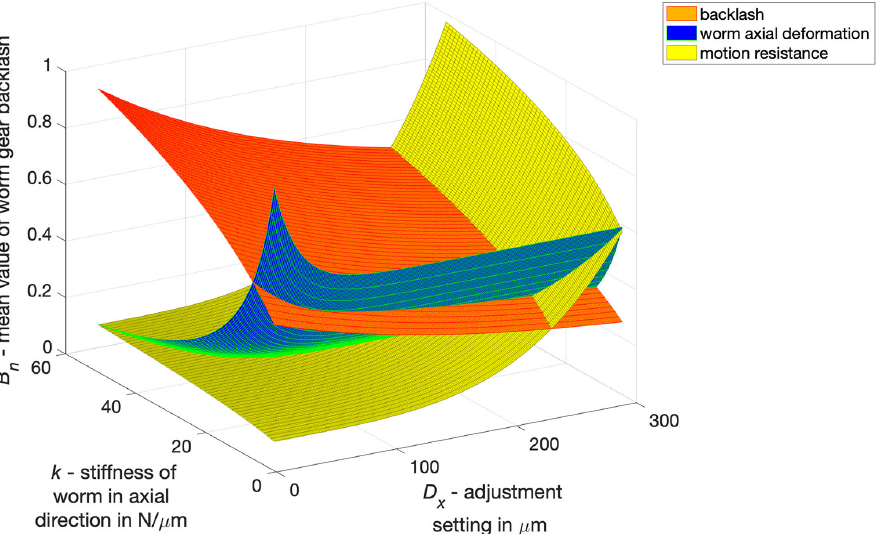
Figure 21. Influence of axial stiffness k and adjustment setting D x on backlash B , worm axial deformation f x and drive motion resistance M (after normalising B , f x and M to the interval <0,